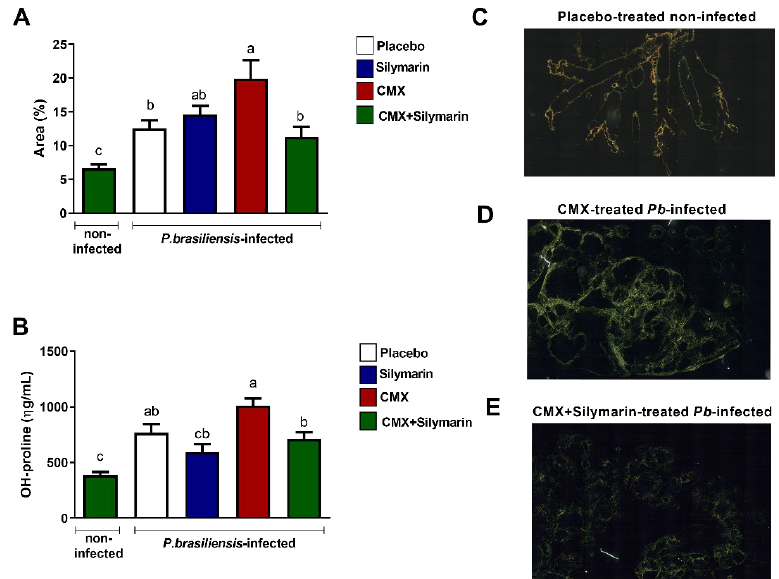
Figure 1. Evaluation of the effects of silymarin in combination with the antifungal cotrimoxazole (CMX) on pulmonary fibrosis parameters. BALB/c mice were infected with P. brasiliensis , and at the 8th week of infection, silymarin/CMX schedule and placebo were started. The mice were evaluated after 12 weeks of treatment. ( A ) Determination of the percentage of collagen fibers in the lungs. ( B ) Quantification of hydroxyproline in the lungs. Values are expressed as η g/mL. ( C ) Section of a normal lung, stained with Sirius red, submitted to polarized light microscopy that was used to visualize birefringent collagen fibers. ( D ) Section of a CMX-treated P. brasiliensis -infected mice, ( E ) Section of silymarin/CMX-treated P. brasiliensis -infected mice. ANOVA with Tukey post hoc test; the values with different superscript letters in a column are significantly different ( p < 0.05).